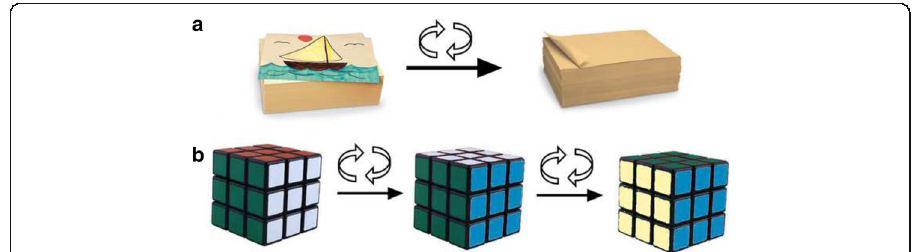
Fig. 2 “ Flipping the flipped. ” Flipping a two-dimensional system, in this case a piece of paper with a sailboat drawn on it, diametrically changes it ( a ), but flipping a three-dimensional system, in this case a Rubik ’ s cube, need not change what is exposed by it (green surface is still exposed at the front after the first flip) and requires additional flips performed in specific directions to create this change ( b